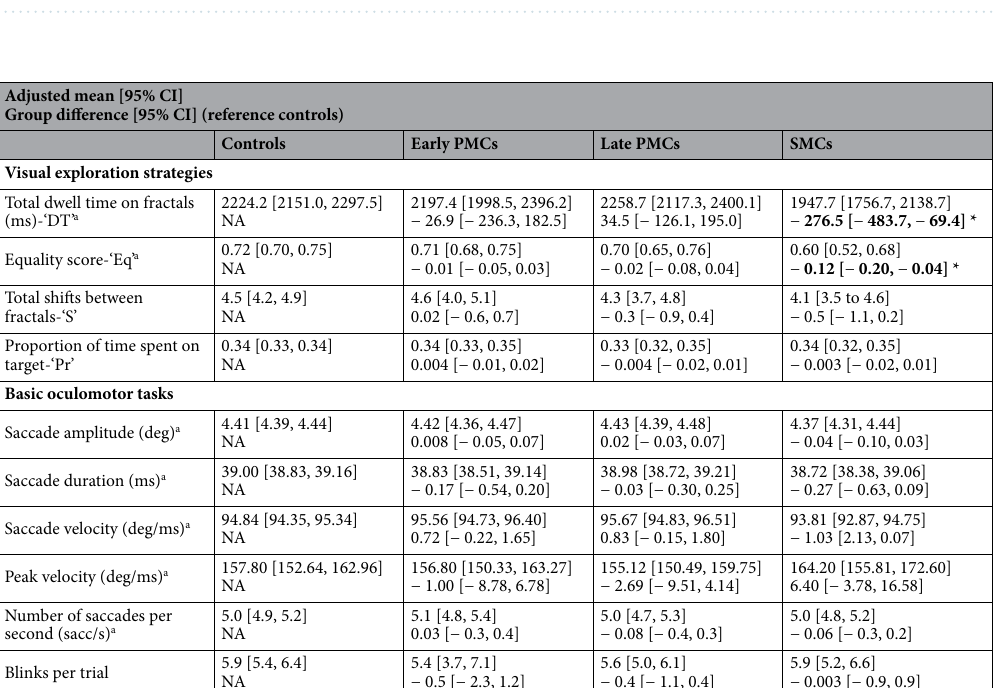
Figure 2. Behavioural VSTM performance by group. Adjusted mean performance (for age, sex and NART) by group. ( a ) Identification accuracy overall and for the higher memory load. ( b ) Localisation error overall and by delay for the higher memory load (deg log-transformed). Error bars represent standard errors of the group means. PMC presymptomatic mutation carrier, SMC symptomatic mutation carrier. **Significant at p < 0.01.